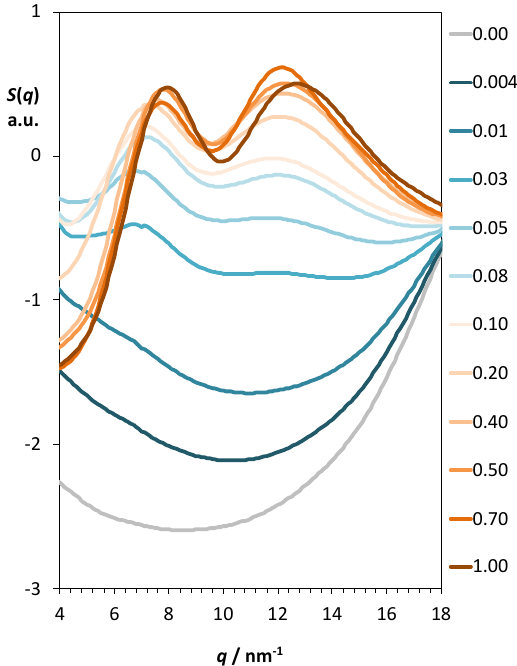
Figure 14. Total structure factor functions, S ( q ) in arbitrary units, of [N 1 2OH 2OH 2OH ][NTf 2 ] aqueous mixtures as a function of mole fraction of water.